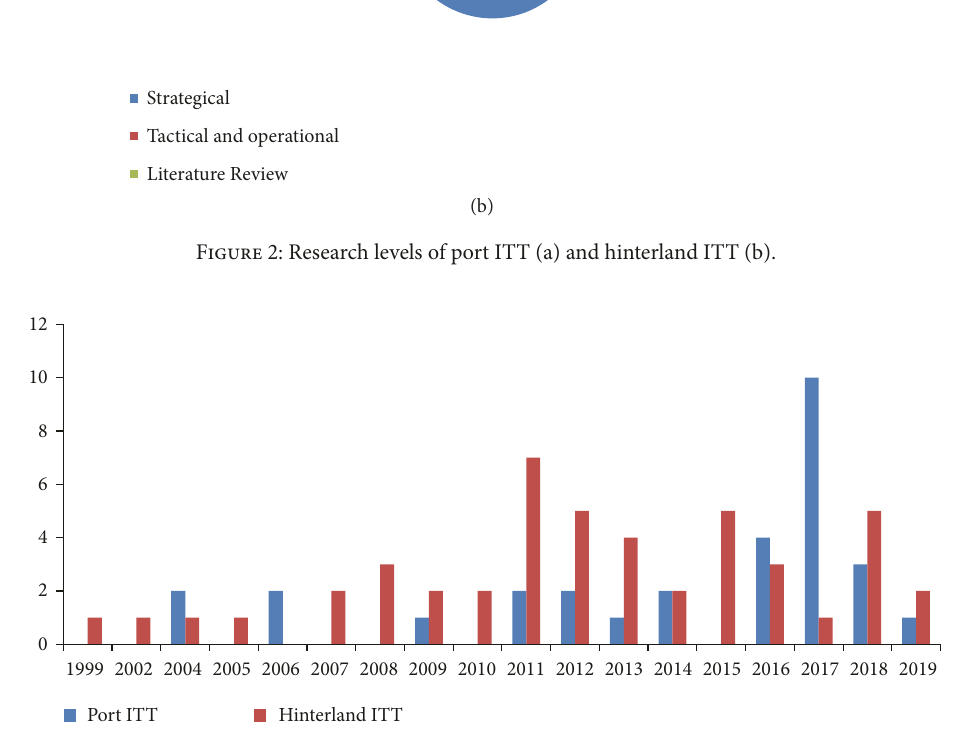
Figure 3: Distribution of journal papers by year of